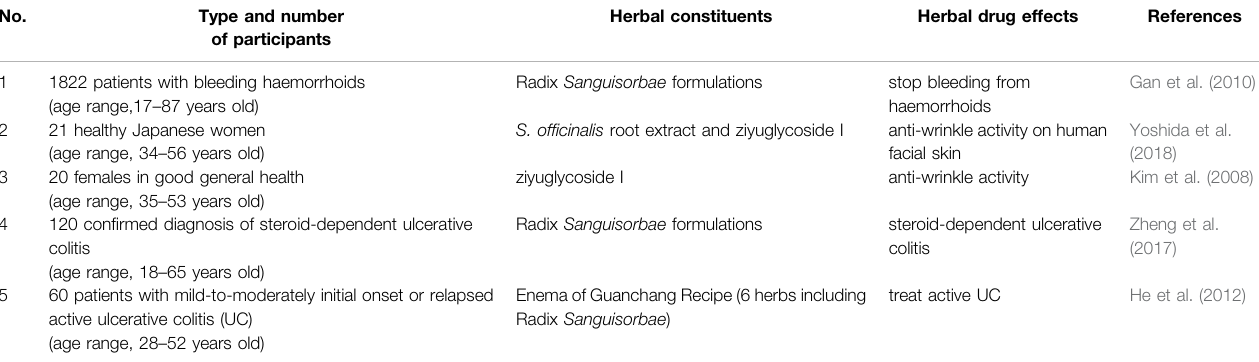
TABLE 2 | Summary of the contemporary clinical uses of S. of fi cinalis . No.